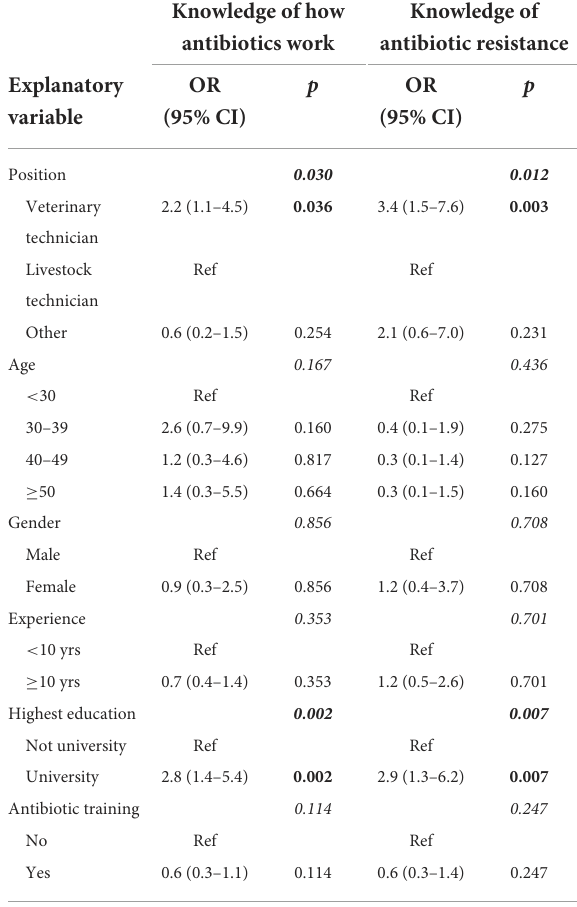
TABLE 5 Crude associations between demographic variables and knowledge of how antibiotics work and antibiotic resistance derived from a series of univariable logistic regression